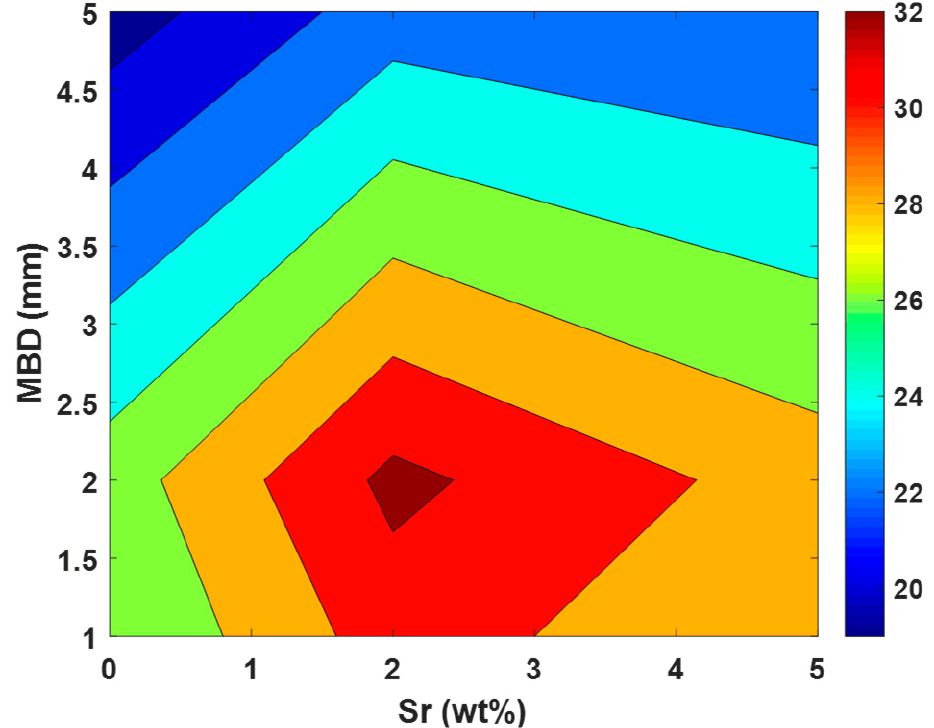
Figure 6. Contour plot related to the effect of strontium amount (Sr) and milling balls diameter (MBD) on the compressive strength of the cements, reported in the colored scale bar, from blue (lower values) to red (higher values).